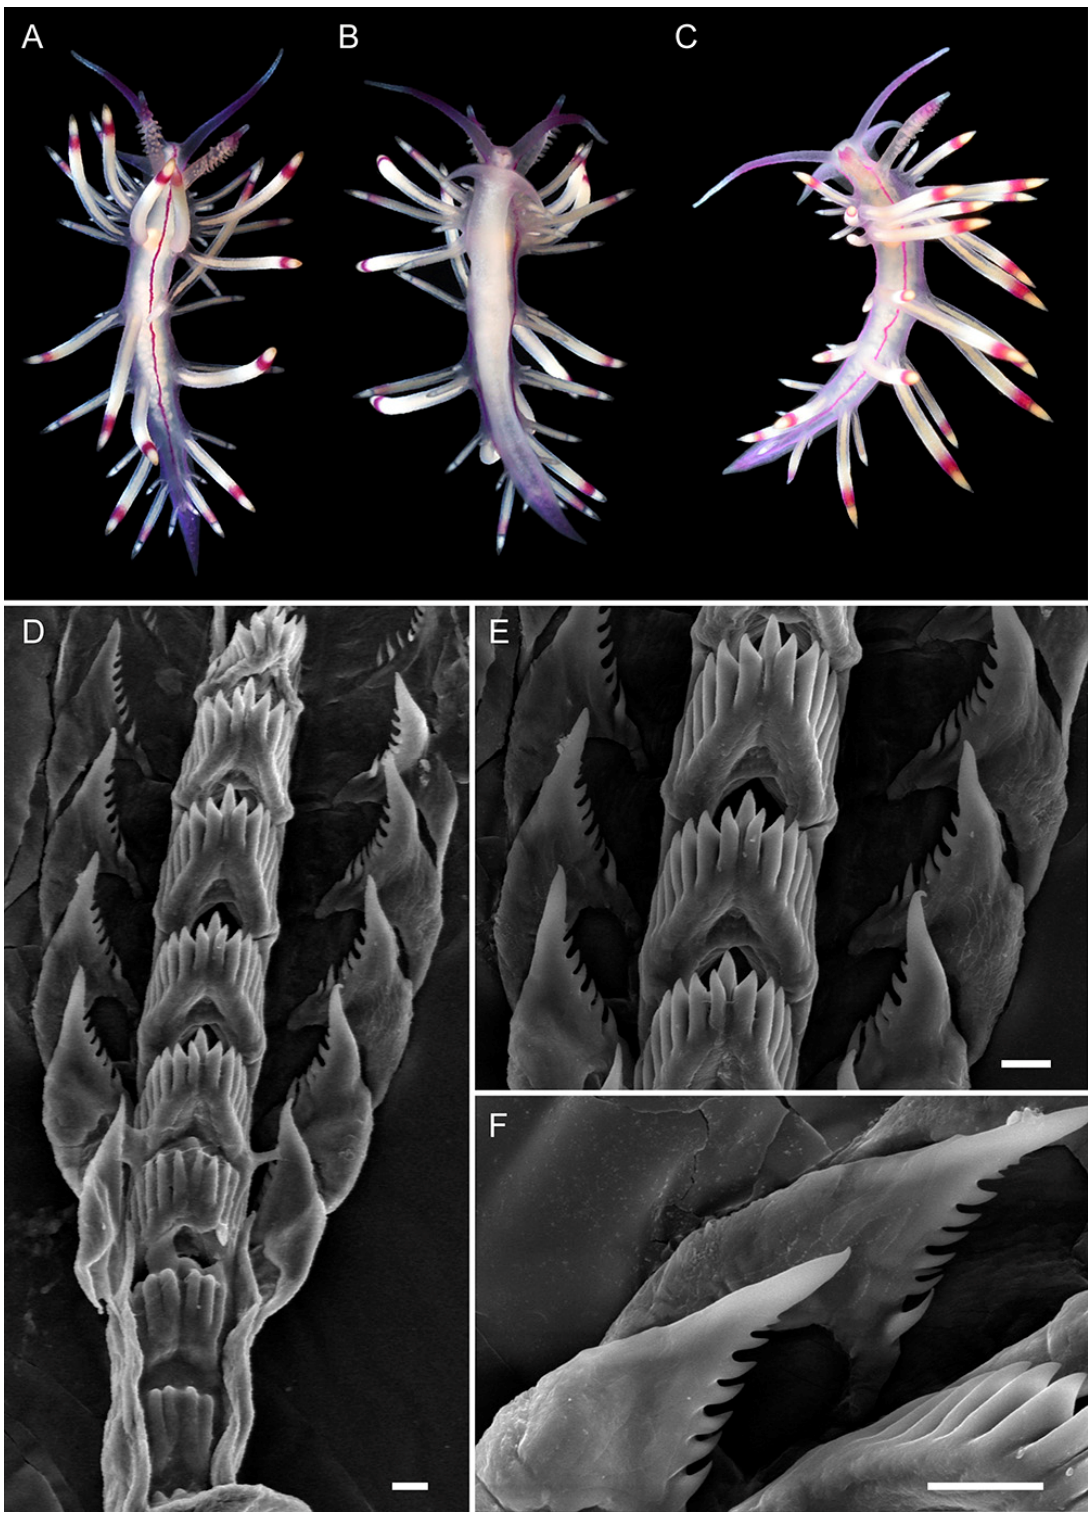
Figure 9. Coryphellina pannae sp. nov. , external morphology and buccal armature. ( A )—paratype ZIN63217, specimen 5 mm in length (preserved), dorsal view. ( B )—paratype ZIN63217, ventral view. ( C )—holotype ZIN63216, specimen 6 mm in length (preserved), dorsal view. ( D )—paratype ZIN63217, posterior radular portion. ( E )—paratype ZIN63217, rachidian and lateral teeth. ( F )—paratype ZIN63217, lateral teeth. Scale bars: 10 μ m. Photo credit: ( A – C ): Yury Deart.